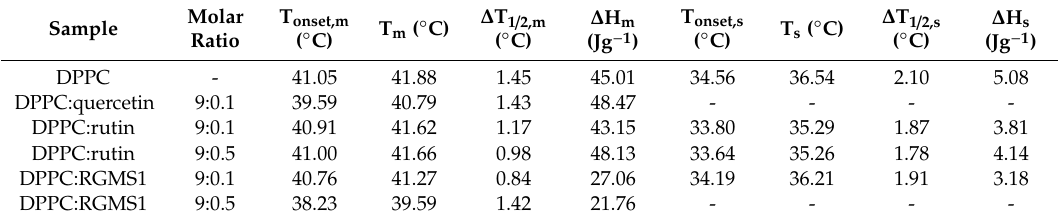
Table 4. The thermodynamic parameter values of transitions observed during heating of the